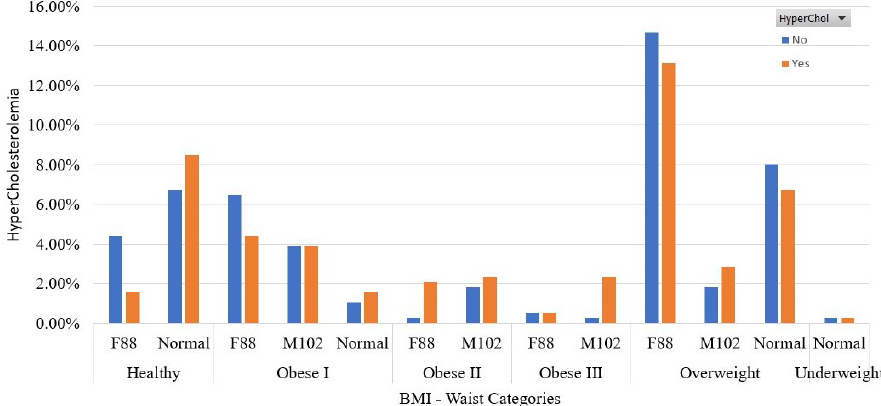
Figure 3. Participants’ distribution in terms of BMI and waist categories in the balanced dataset.